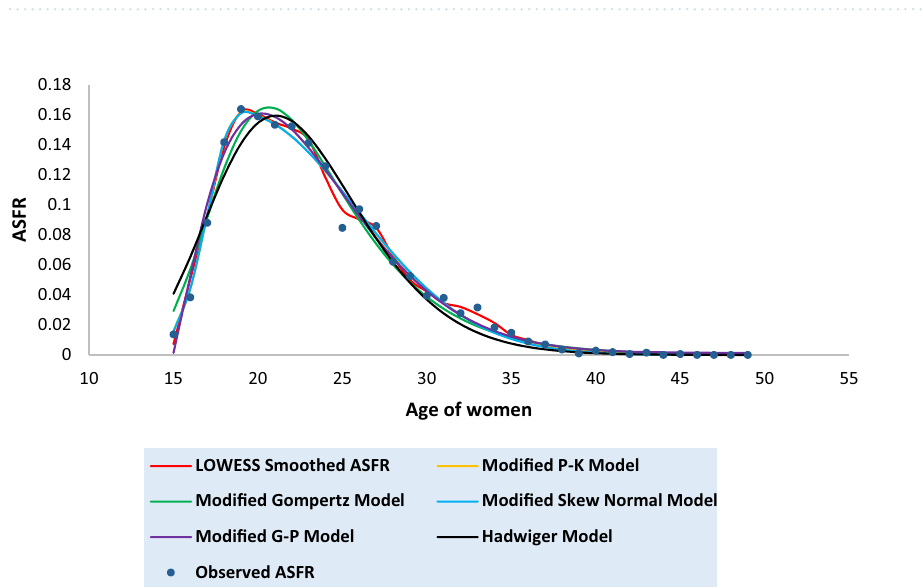
Figure 6. Observed and expected age-specific fertility rate (ASFR) for West Bengal under different proposed models and Hadwiger